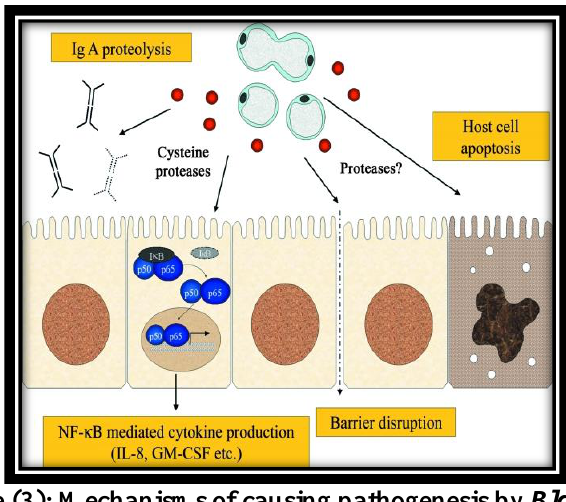
Figure (3): Mechanisms of causing pathogenesis by Blastocystis.